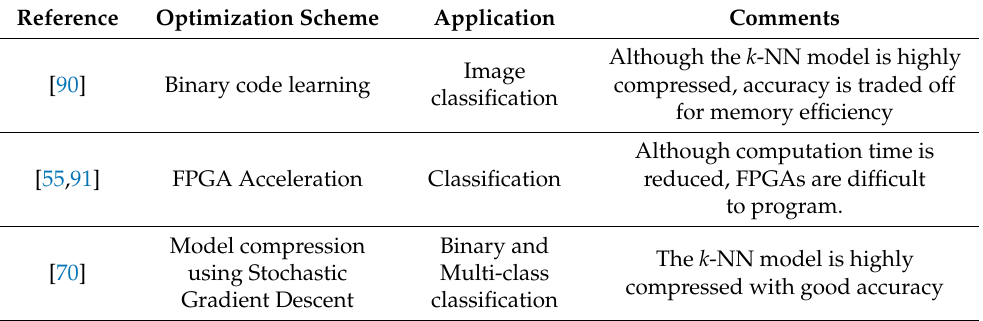
Table 6. Some kNN optimization